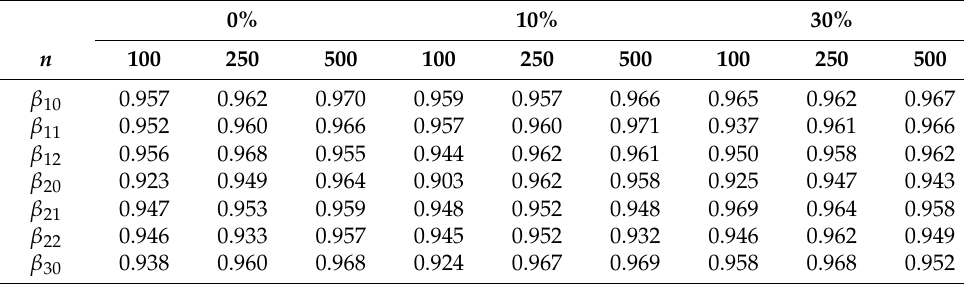
Table 2. CPs for the 95% confidence intervals from the simulated OLLW regression